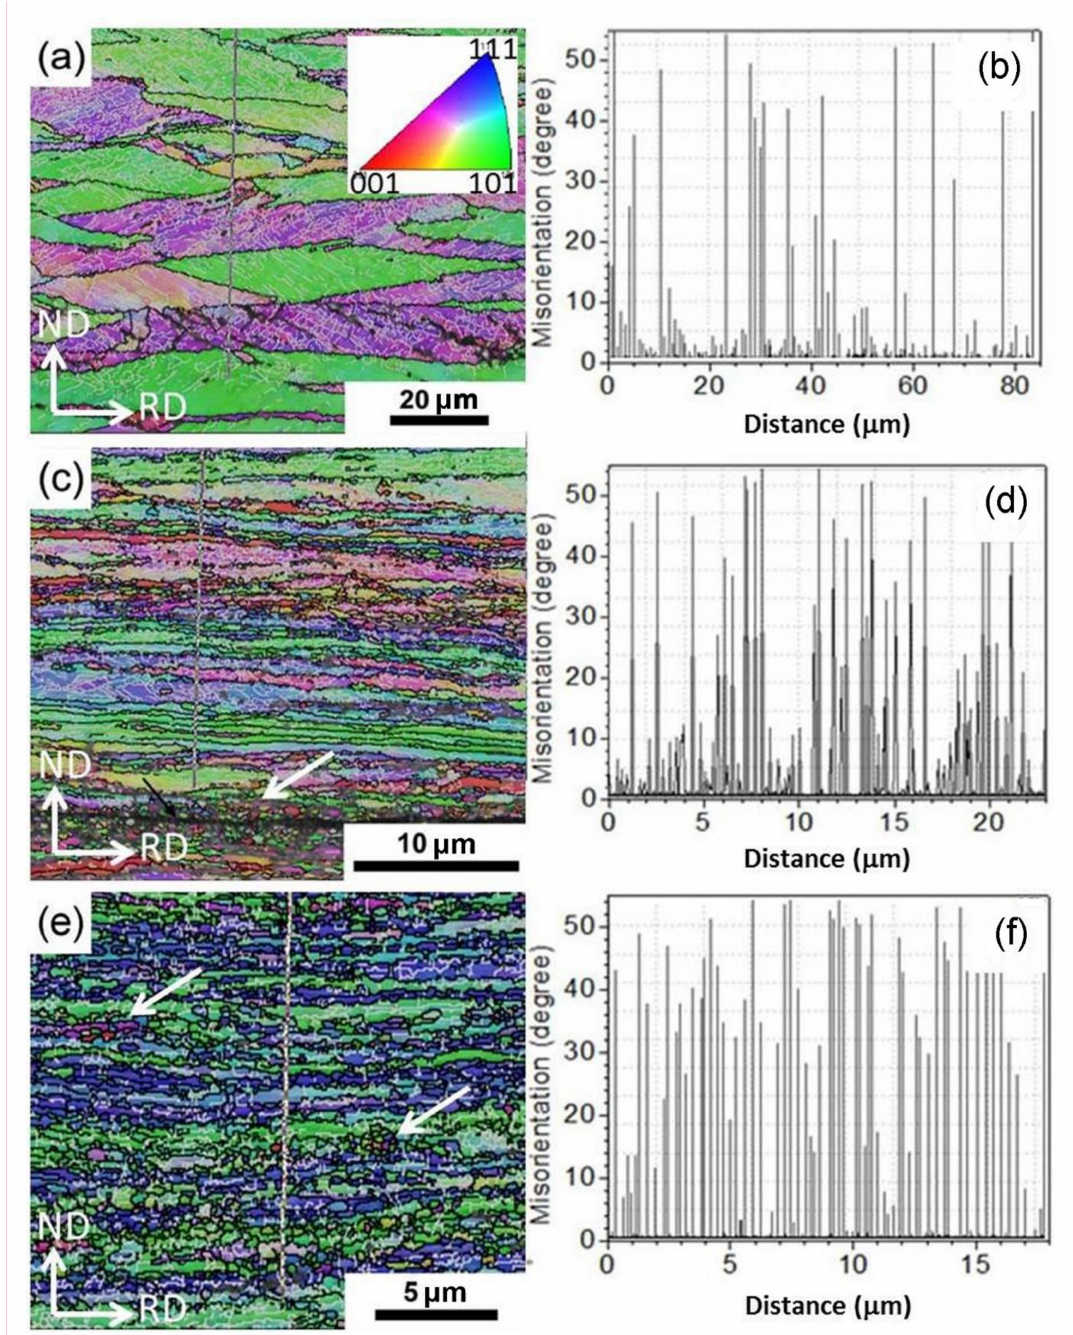
Figure 2. EBSD crystal orientation inverse pole figure (IPF) maps ( a , c , e ) and corresponding misorientation distributions ( b , d , f ) along the lines from top to bottom of ARBed Cu with ( a , b ) 1 pass, ( c , d ) 3 passes, and ( e , f ) 6 passes. The inset is color coded, in which red, green, and blue indicate grains having < 001 > , < 101 > , and < 111 > directions perpendicular to the plane, respectively. The gray lines represent the LAGBs with a misorientation angle θ of 2 ◦ ≤ θ < 15 ◦ , and the black lines represent HAGBs with a misorientation of θ > 15 ◦ . The bin size of the misorientation distributions ∆ θ is 2 ◦